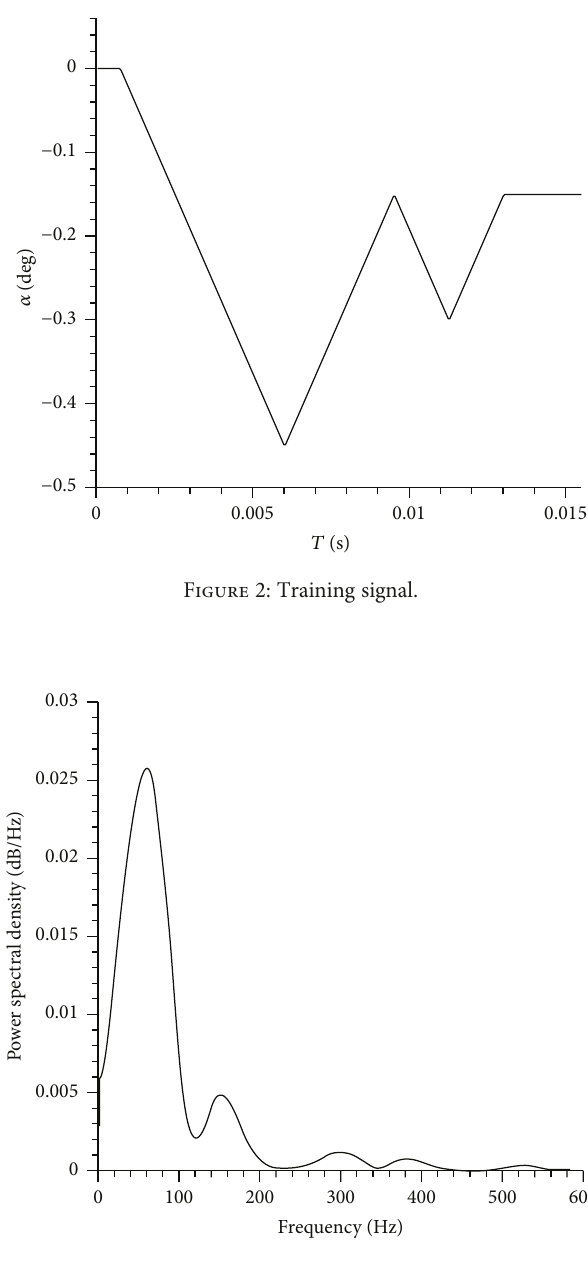
Figure 3: The power spectral density of the training